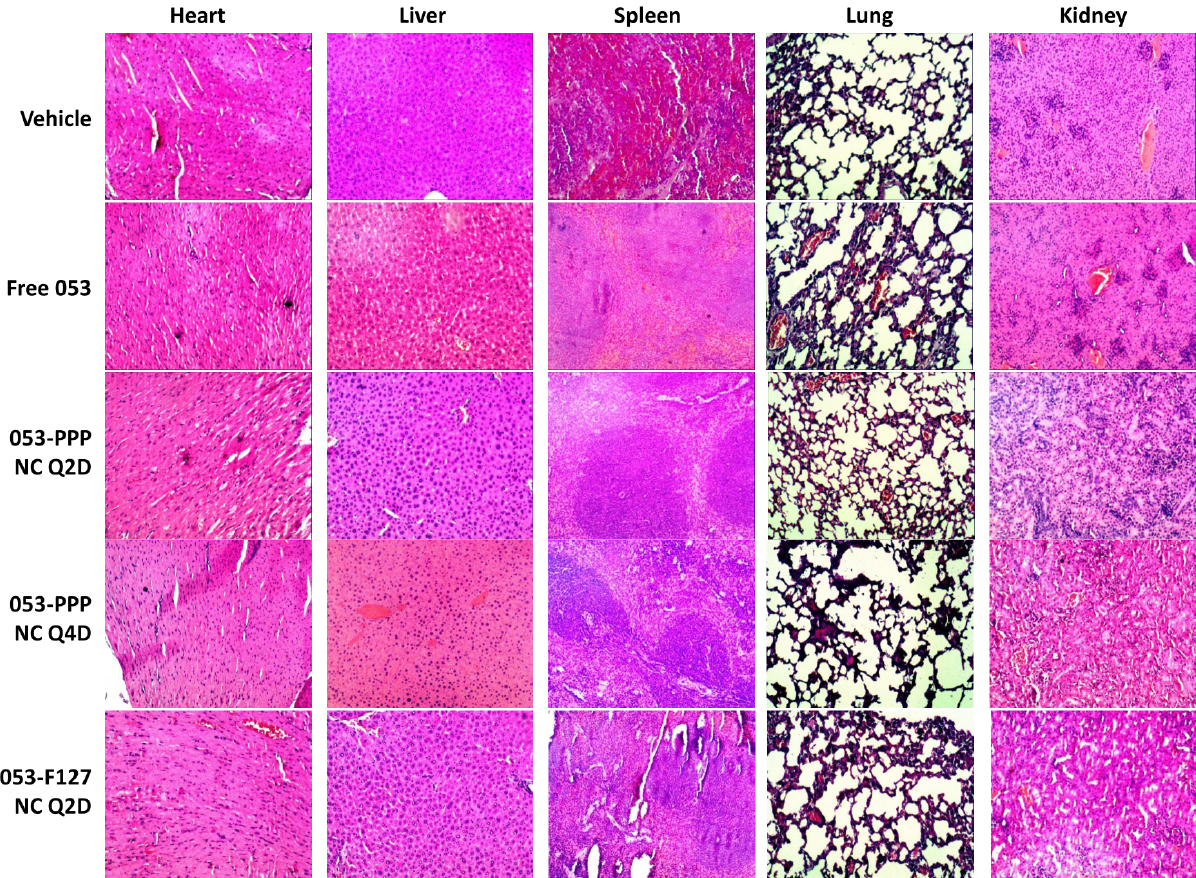
Figure 9. Evaluation of in vivo safety: representative micrographs of HE staining of histological sections of major organs (including the heart, spleen, kidneys, liver, and lungs). Magnification: 100×.